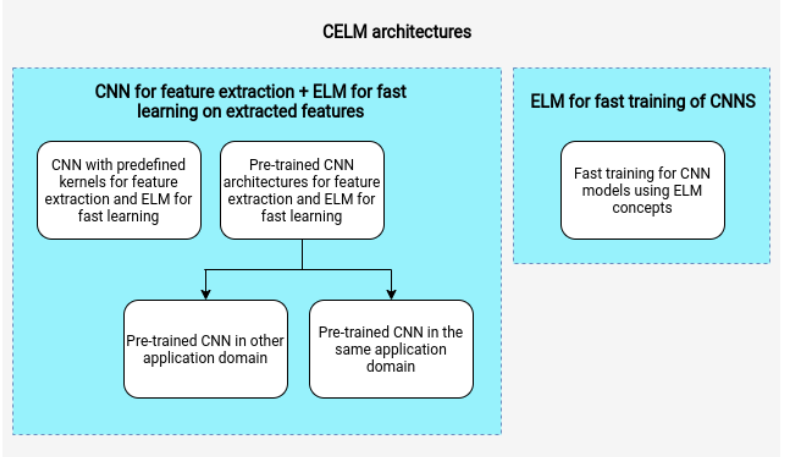
Figure 4. CELM architectures proposed in the